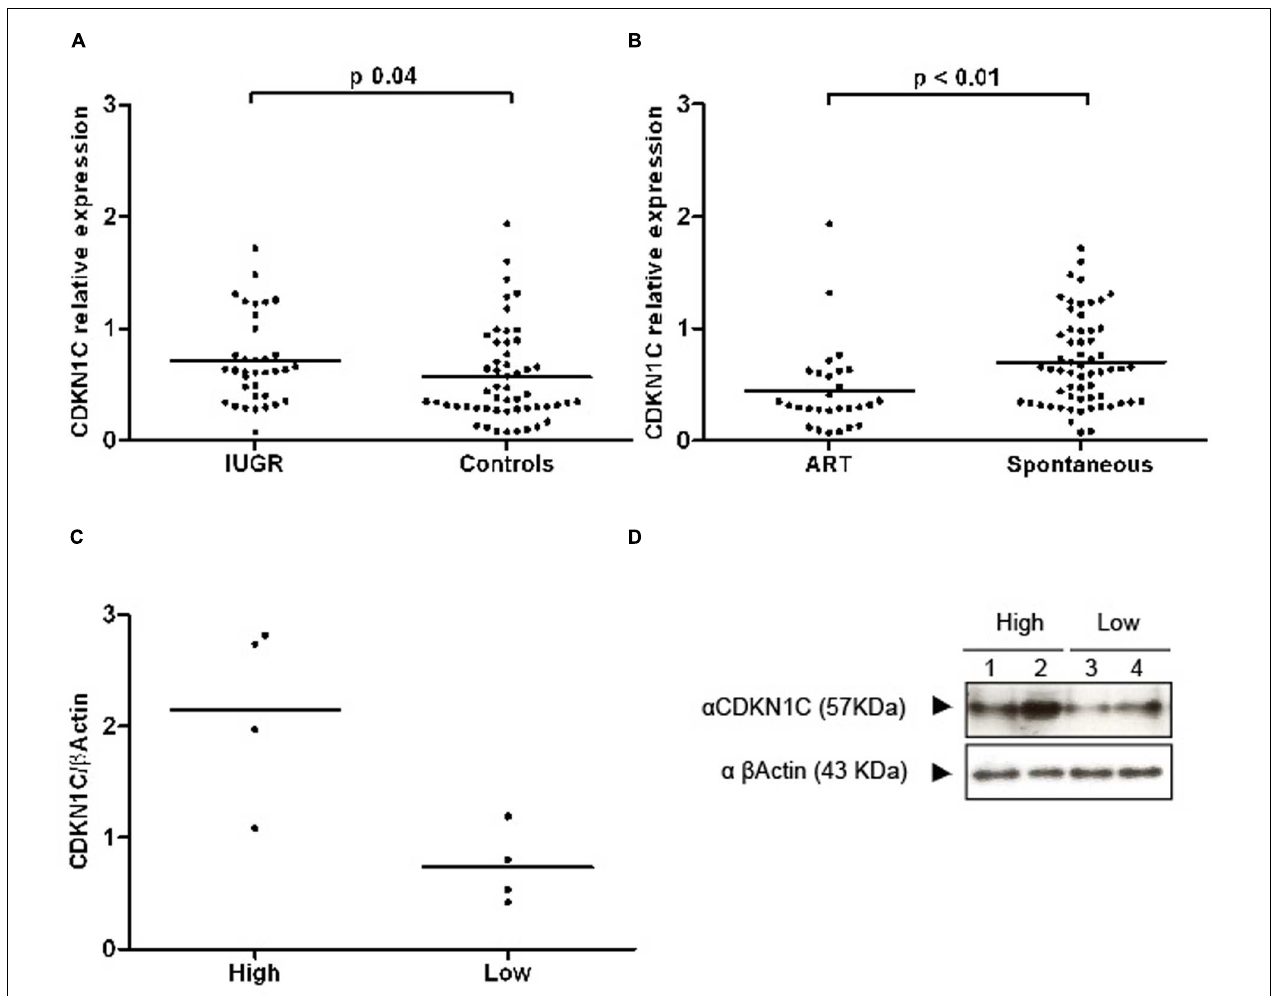
FIGURE 2 | Scatter plots representing RQ (relative quantification) values of CDKN1C transcripts and proteins. (A) A graph showing the transcript abundance of CDKN1C in IUGR and control placenta samples with the line representing the median. (B) The expression profile in ART and spontaneously conceived samples. (C) Quantification of protein expression differences in lowly and highly transcribed placenta samples. (D) An example of a western blot used for protein